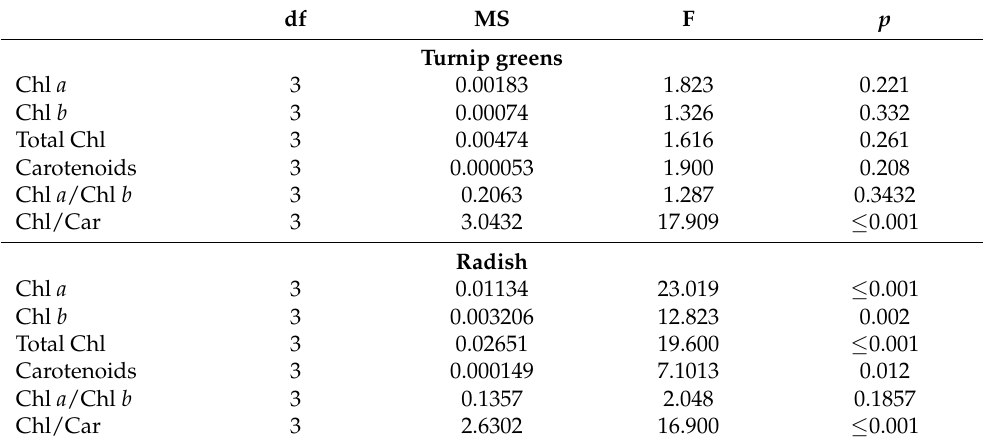
Table 2. Results of one-way ANOVA for chlorophyll a (Chl a ), b (Chl b ), total chlorophyll (Total Chl), carotenoids, chlorophyll a / b ratio (Chl a /Chl b ), and chlorophyll/carotenoid ratio (Chl/Car), in microgreens of turnip greens and radish.